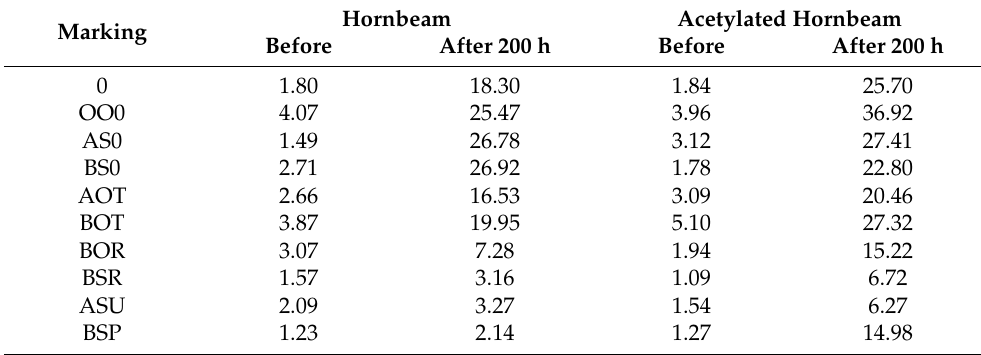
Table 4. Color variation of xenon-lamp-irradiated hornbeam (color difference compared to average color). Average values of 20 measurements are presented.